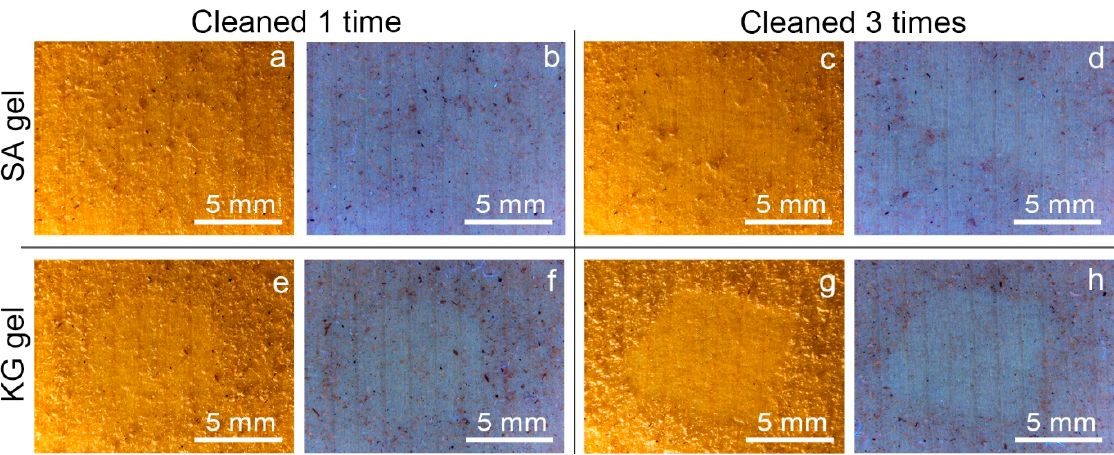
Figure 4. Stereomicroscopy images in visible and UV light of soiled-WM cleaned at different application times with SA and KG gels: ( a , b ) SA_1, ( c , d ) SA_3, ( e , f ) KG_1, and ( g , h ) KG_3.